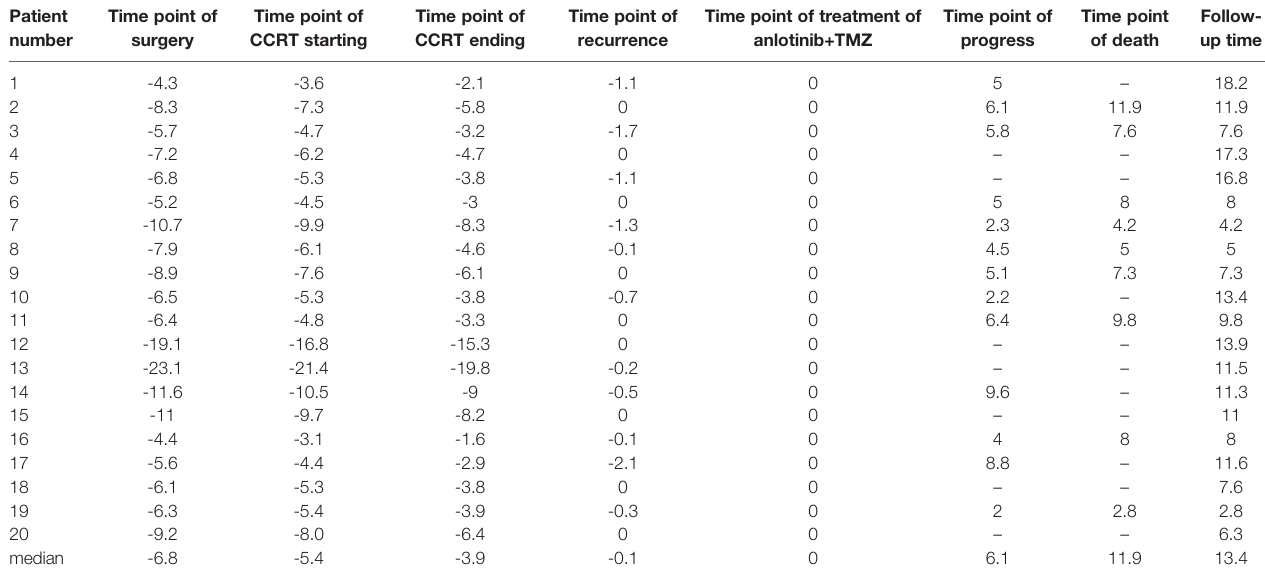
TABLE 3 | Treatment timeline of 20 patients with